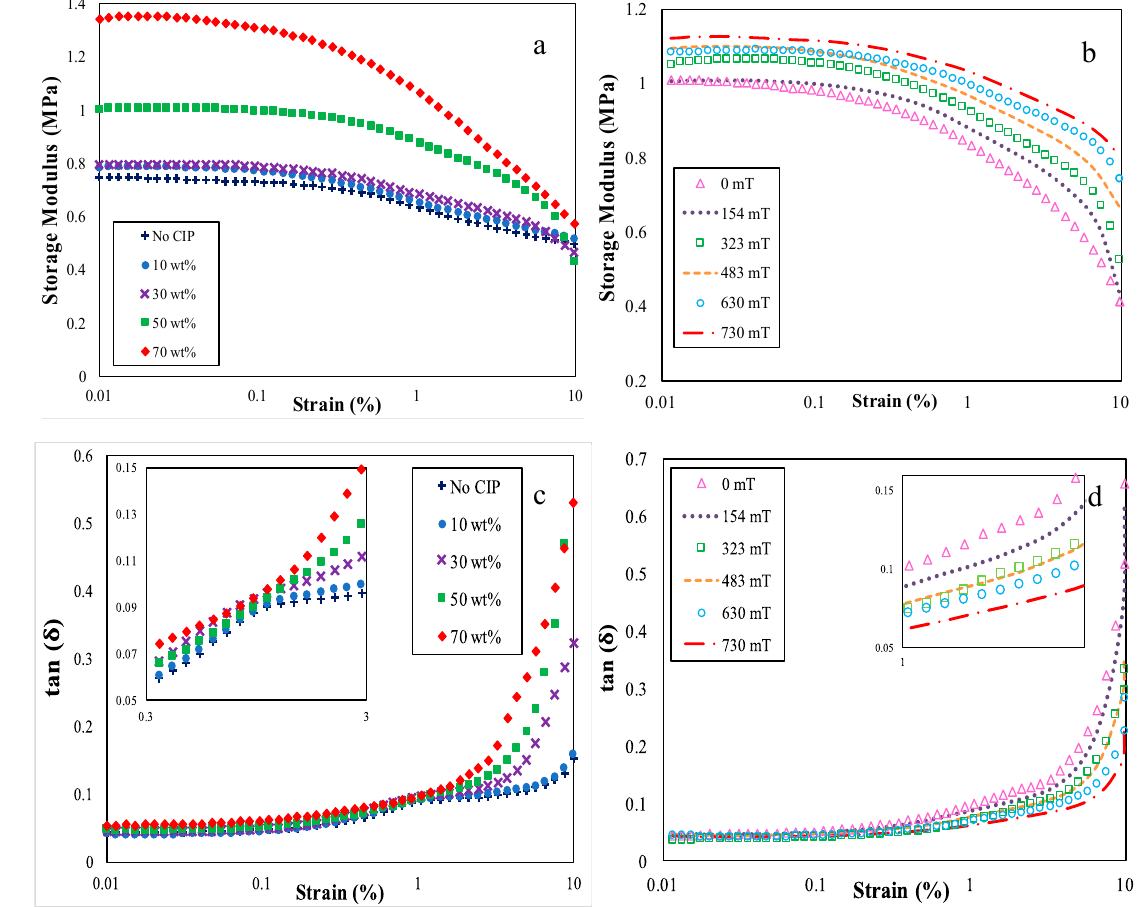
Figure 5. Results of ( a , b ) storage modulus, and ( c , d ) loss factor of ENR-based MREs at different CIP content and magnetic fields for various strain amplitudes.